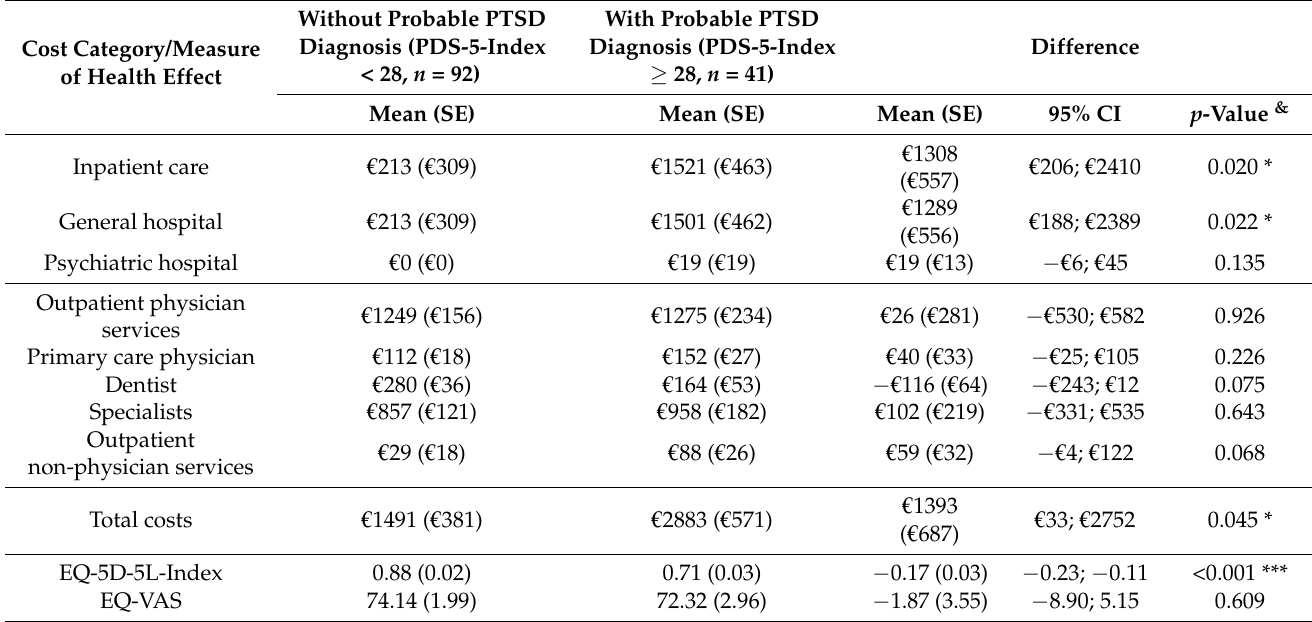
Table 3. Mean annual health care costs and health-related quality of life of refugees with and without a probable PTSD diagnosis ( n =